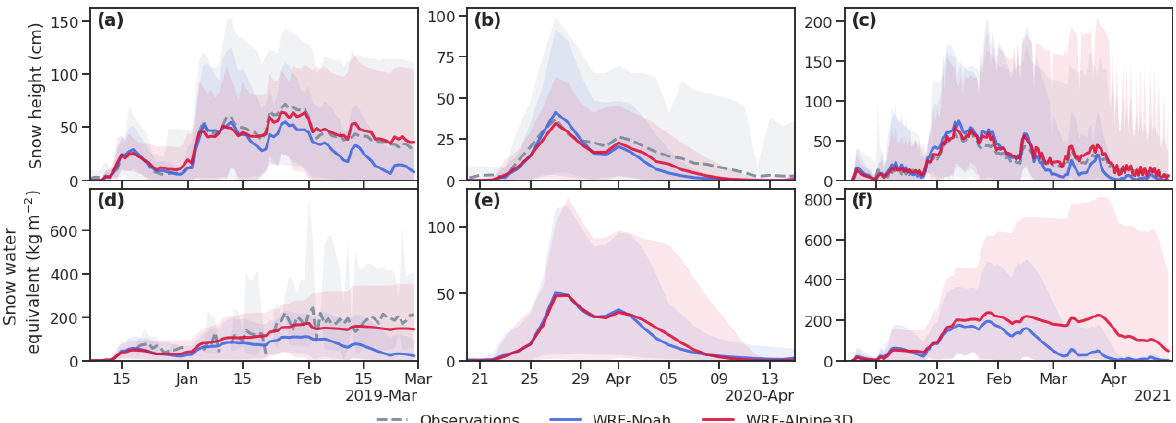
Figure 4. Time series of observed and simulated snow height (a, b, c) and snow water equivalent (d, e, f) for the three snow seasons. Solid lines represent the mean of all available stations for each snow season considered: observations are indicated by a solid gray line, while simulations are indicated by solid blue and red lines, corresponding to WRF–Noah and WRF–Alpine3D, respectively. The shaded areas correspond to the maximum and minimum snow height and snow water equivalent observed or simulated. The low temporal frequency of the manual measurements for snow seasons 2019/20 and 2020/21 and the non-contemporaneity of the observations at different sites make the time series of the mean observed snow water equivalent noisy and uninformative; thus we decided to not show them in panels (e) and (f) .